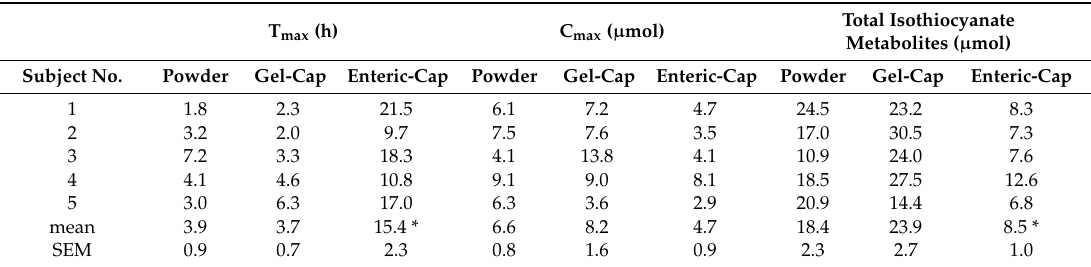
Table 1. Urinary excretion of isothiocyanate metabolites after administration of one gram of broccoli sprout powder in water or delivered in normal gelatin capsules or enteric coated capsules. T max (h) C max ( µ mol)